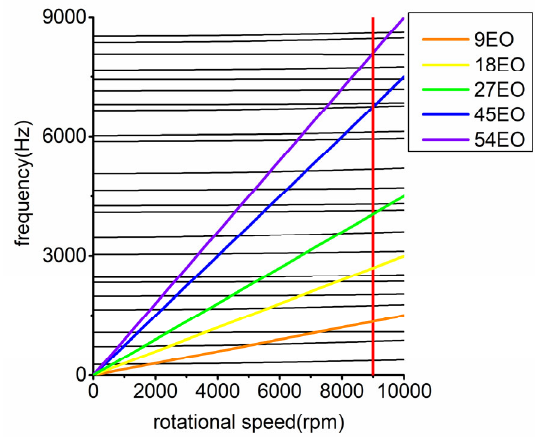
Figure 16. Campbell diagram of R1 rotor blade.